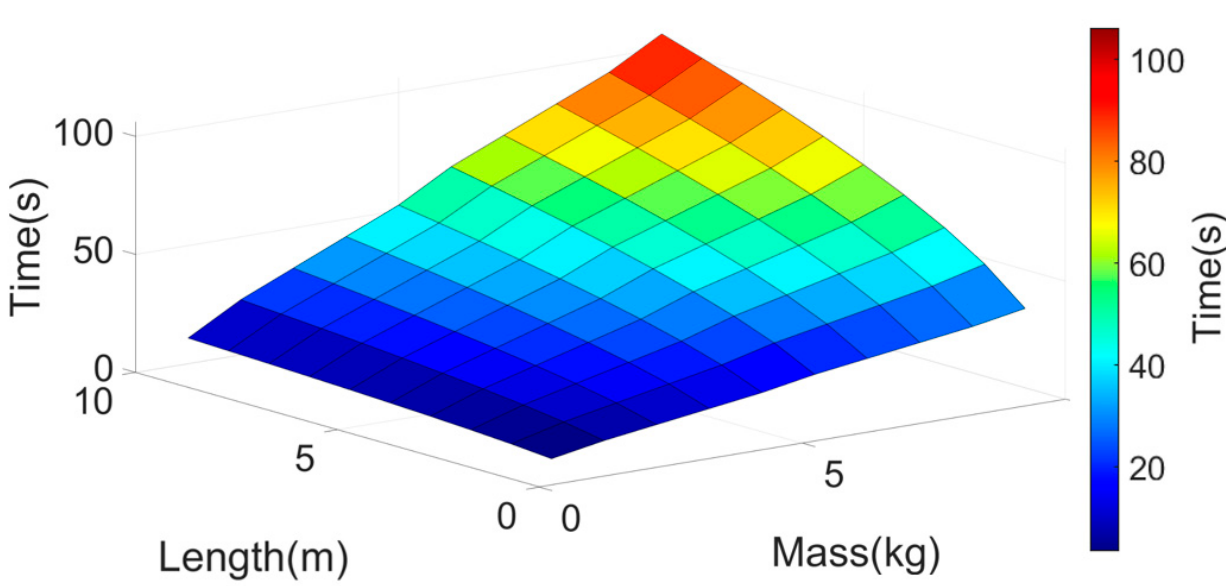
Figure 4. Time to reach the angle of generation according to the mass and length of the pendulum.